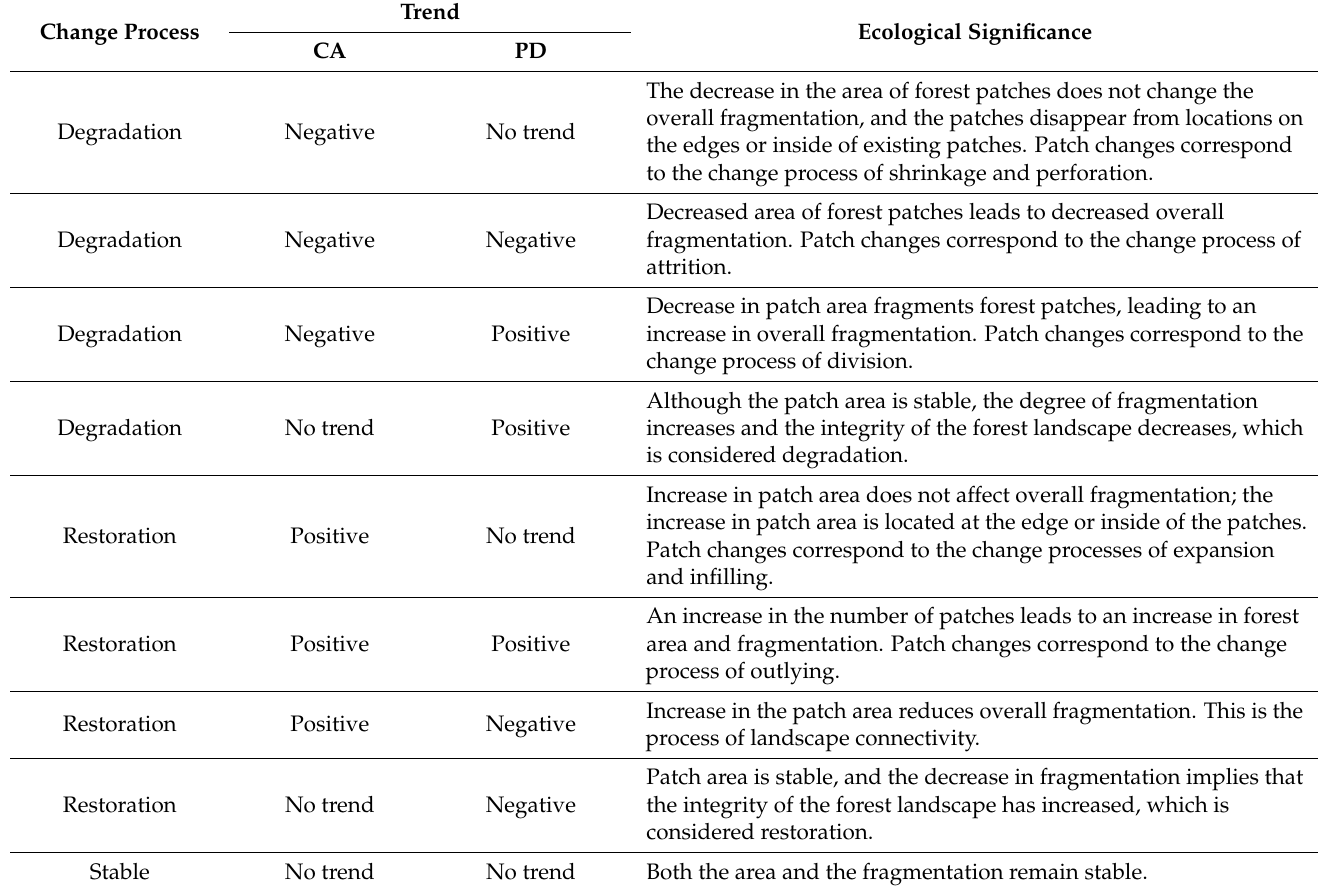
Table 2. Definitions of the change processes based on CA and PD trends.